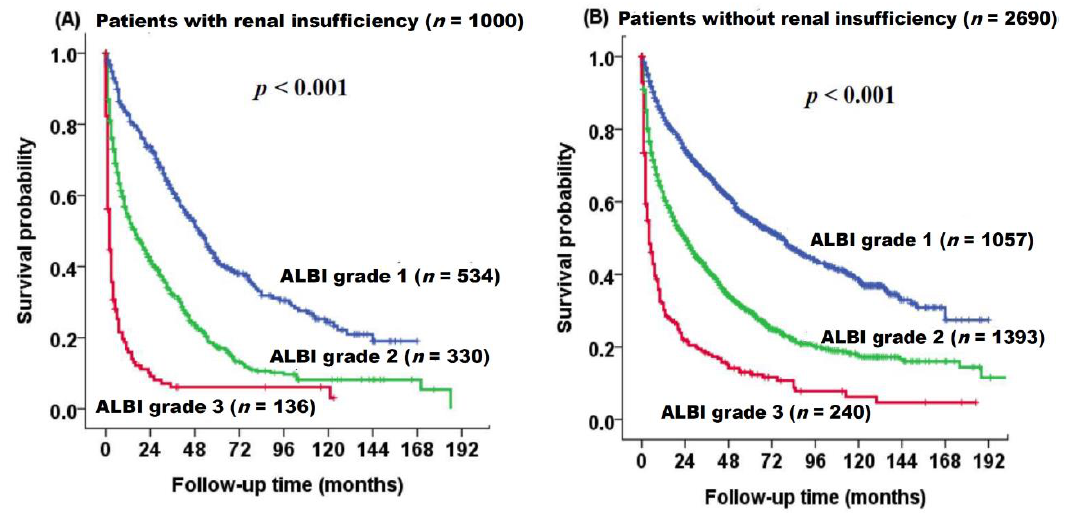
Figure 3. Survival distribution of HCC patients with ( A ) and without ( B ) renal insufficiency based on ALBI grade analyzed by the Kaplan–Meier method with log-rank test. Patients with ALBI grade 2 and 3 had increased risks of mortality compared to those with ALBI grade 1 in both patient cohorts ( p < 0.001).